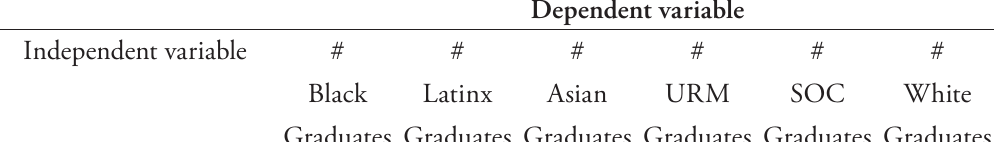
Table 3. Unstandardized Coefficients for Random Effects Analyses